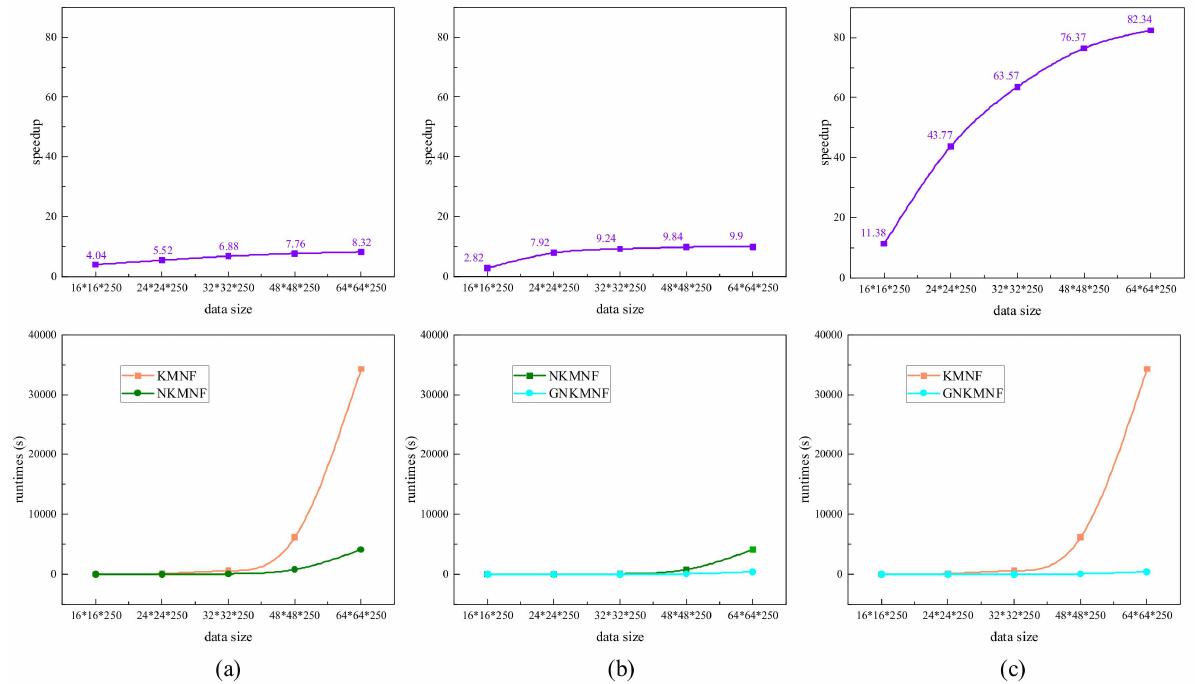
Figure 16. Computational cost comparisons for KMNF transformation, NKMNF transformation, and GNKMNF transformation with different data volumes. ( a ) Computational cost comparison of KMNF transformation and NKMNF transformation; ( b ) Computational cost comparison of NKMNF transfor- mation and GNKMNF transformation; ( c ) Computational cost comparison of KMNF transformation and GNKMNF